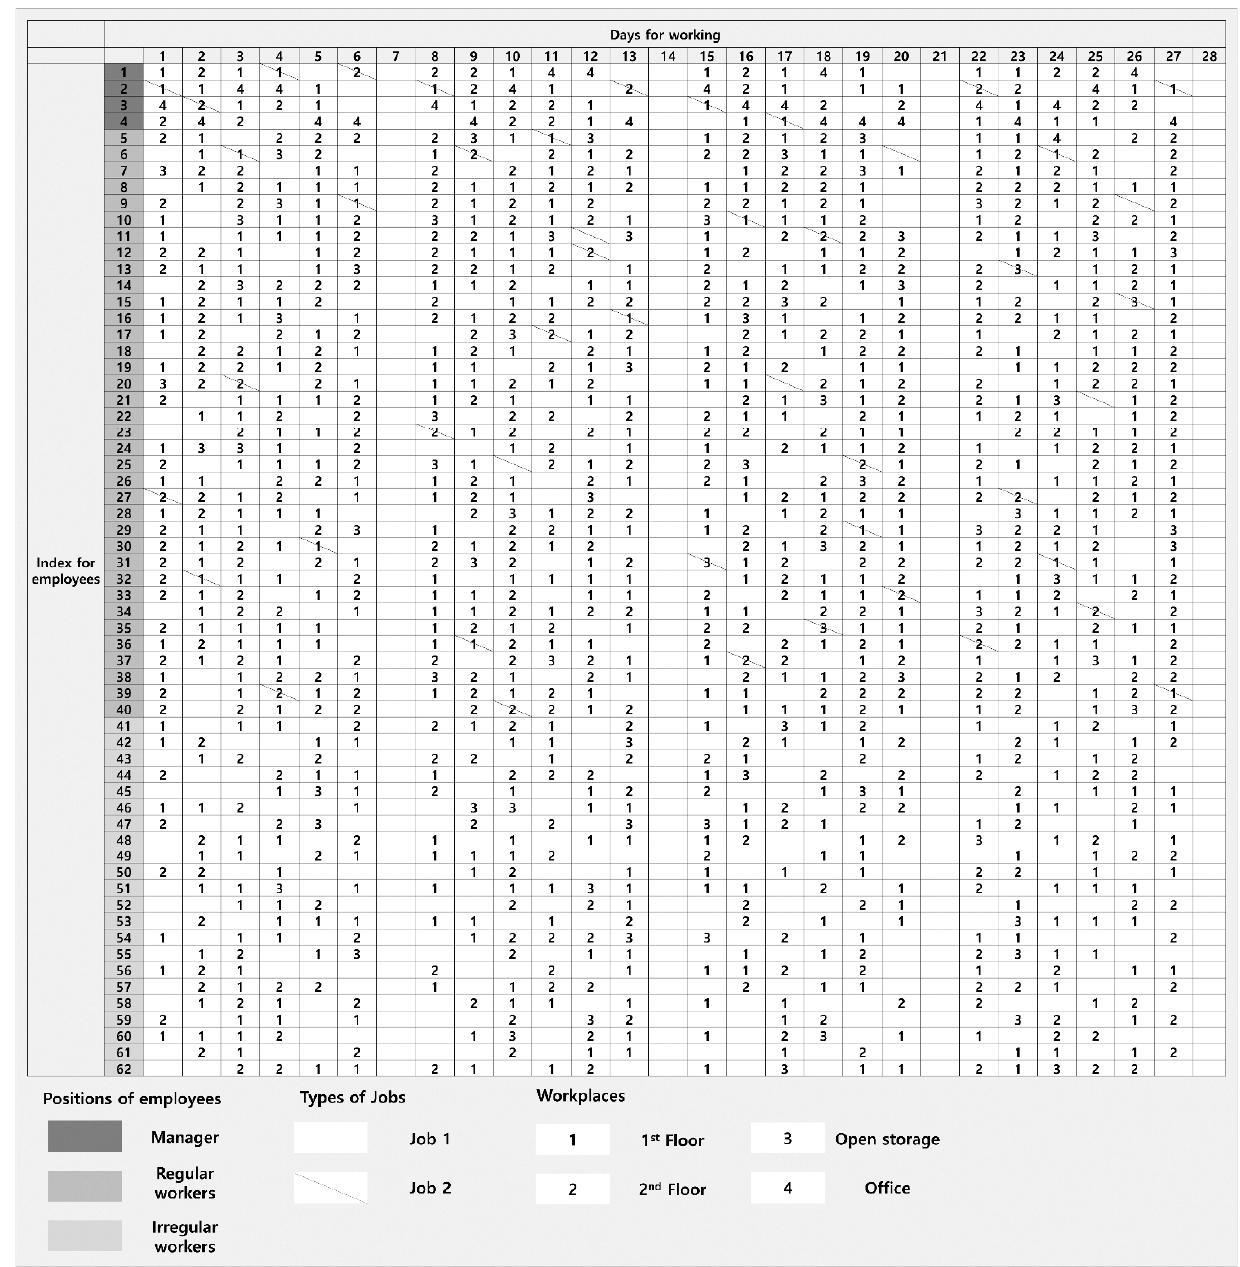
Figure 3. A staff schedule before applying a mathematical model.